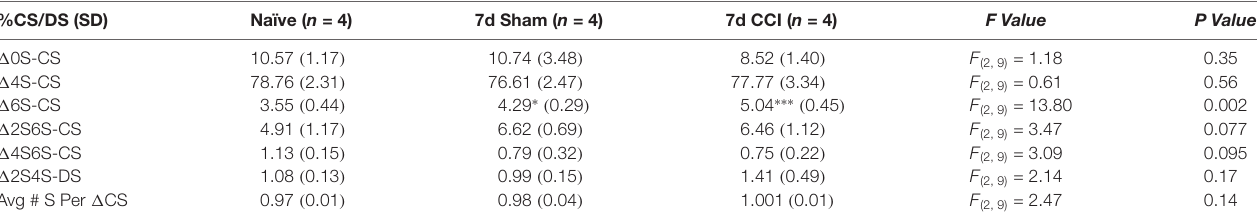
TABLE 2 | Relative percentages of CS isomers in the means of 10 representative thalamic isolations spanning the rostro-caudal extent of the injury site ( − 1.0, − 1.5, − 2.0, − 2.5, and − 3.0 mm from the Bregma) of mice used in the rotarod